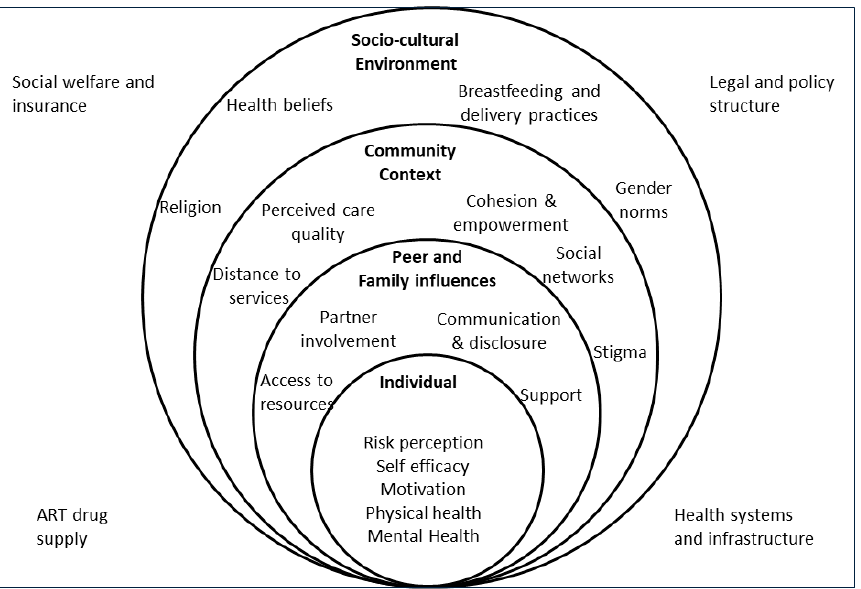
Figure 2. Social ecological framework for determinants of uptake, adherence and retention in Pre- vention of Mother to Child Transmission (PMTCT) program (adapted from Busza et al., 2012).